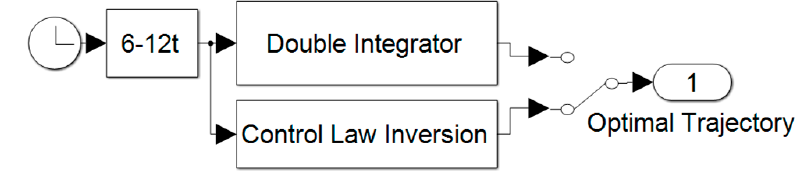
Figure A2. Pre- fi ltering simulation topology.